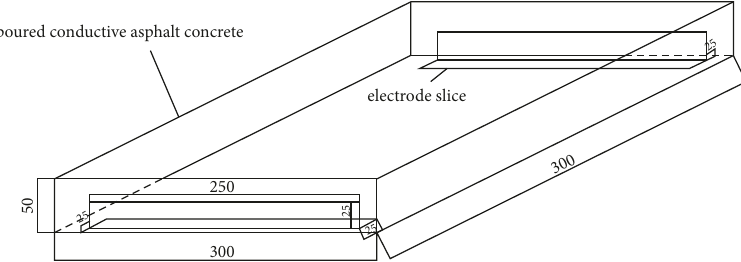
Figure 4: The specimen for electrical resistivity